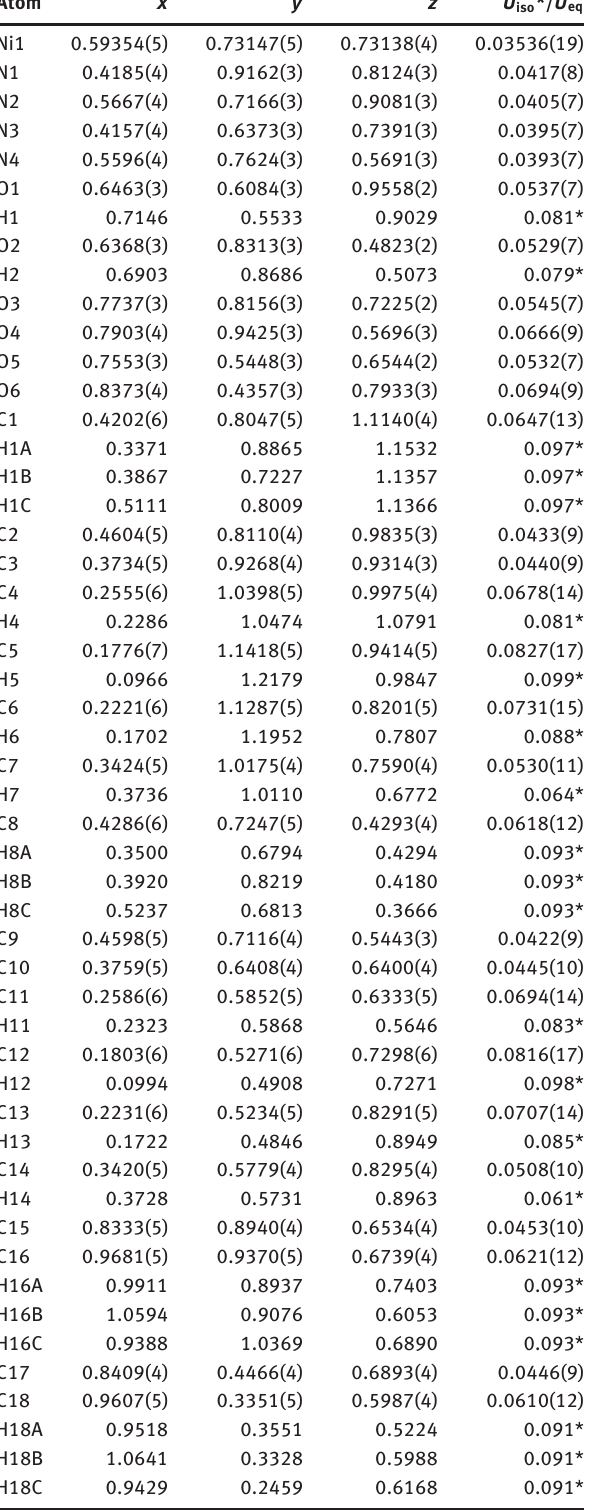
Table 2: Fractional atomic coordinates and isotropic or equivalent isotropic displacement parameters (Å 2